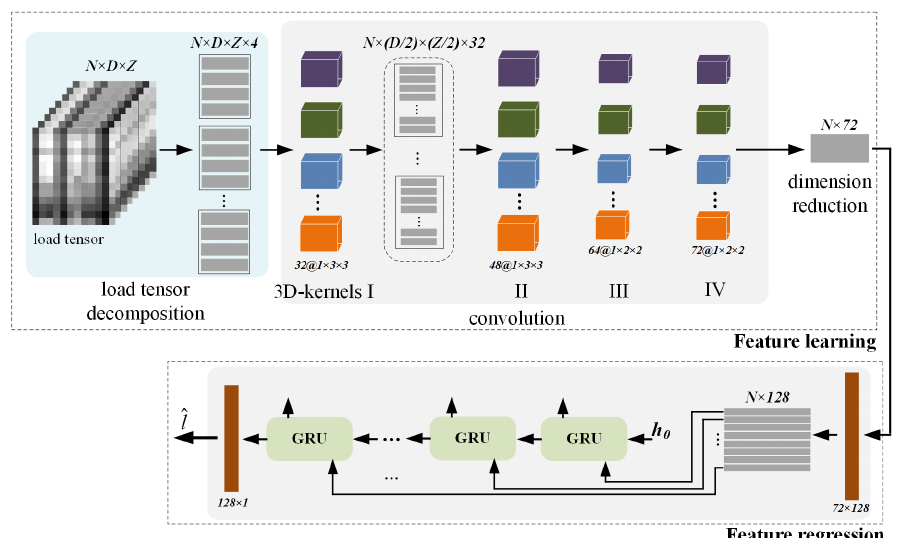
Figure 4. Illustration of the proposed forecasting model. In the feature learning module, the convolution stride of the frame direction is set to one, and the height and width direction are two, while the padding is “SAME”. Activation function selects the rectified linear unit (ReLU). The employed classical GRU [30] has a hidden layer of 128. Note that a typical size of load tensor matching this framework is 8 × 14 × 12, where “8” indicates that the load values at eight consecutive time points before the forecasted hour are adopted and “14” means that each time point contains data for fourteen consecutive